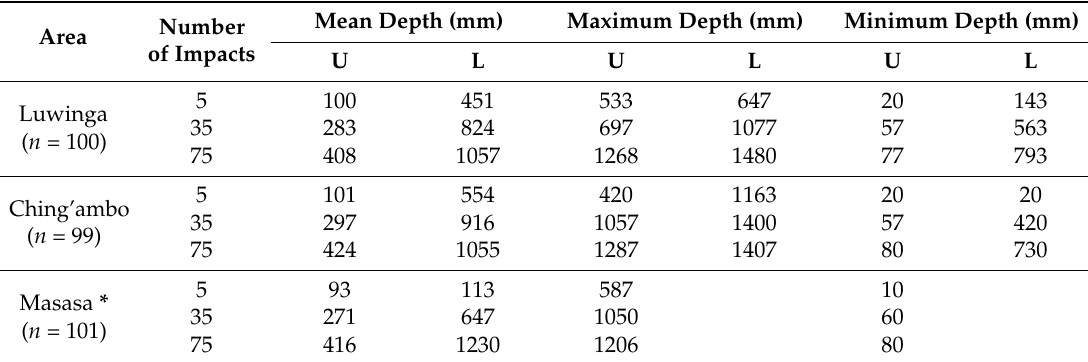
Table 2. Sludge strength based on impact